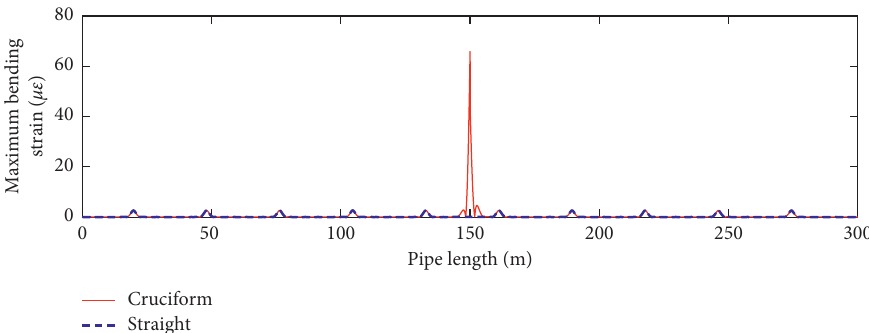
Figure 13: Maximum bending strain of straight pipe and cruciform connections.